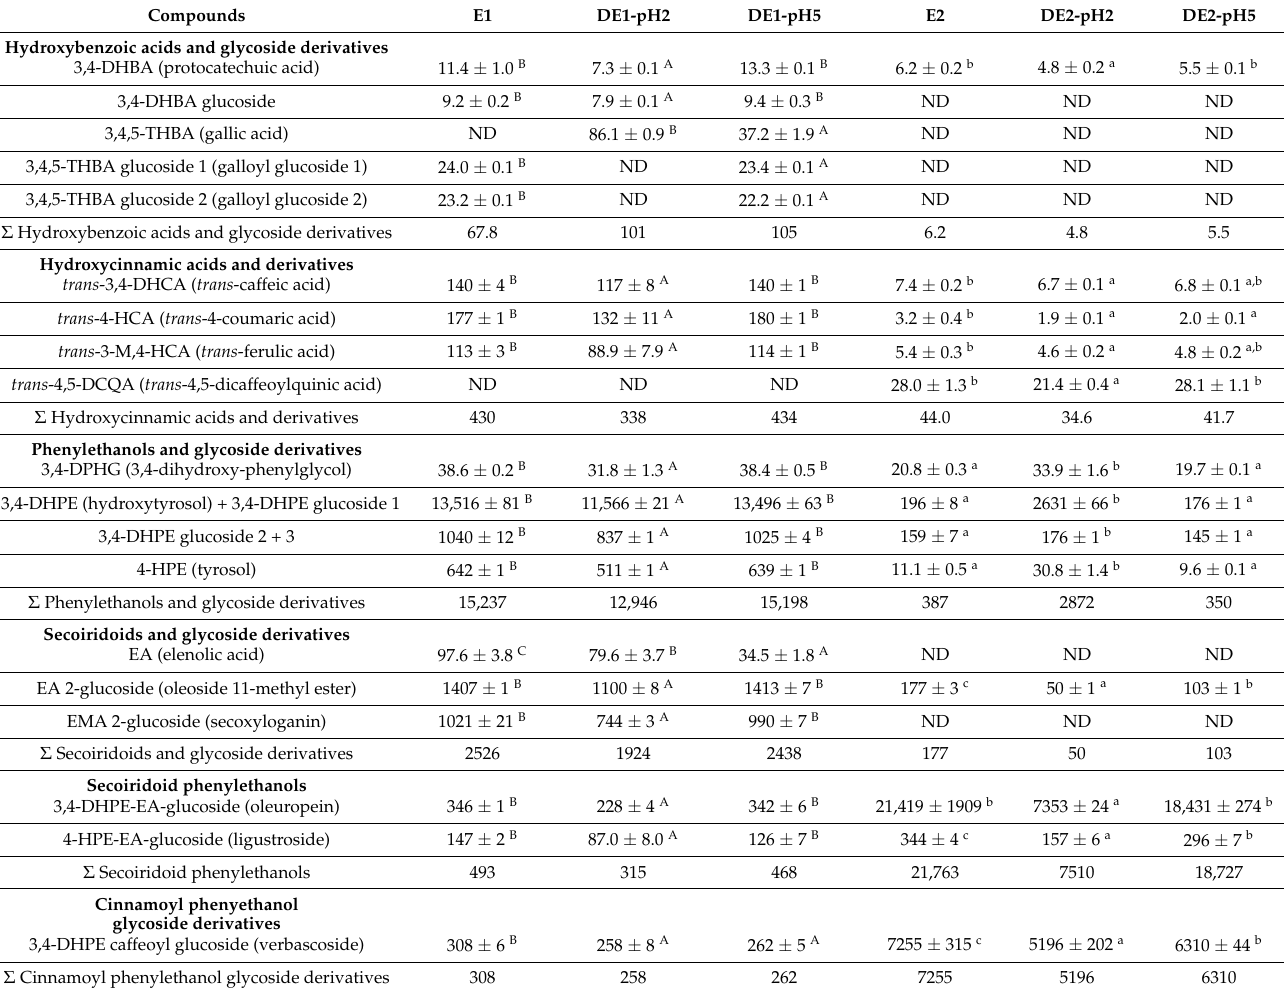
Table 1. Content of identified phenolic and secoiridoid compounds and their derivatives present in the non-digested (E1 and E2) and gastric digested extracts (DE1 and DE2) at fasted (pH 2) and fed state (pH 5) conditions. Results are expressed as mean value ± standard deviation (mg/100 g of dry